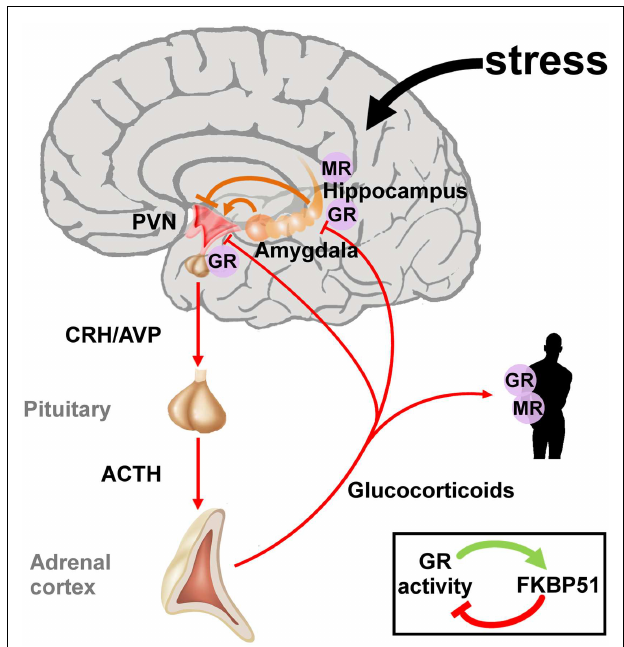
FIGURE 2 |The hypothalamic-pituitary-adrenal axis integrates and mediates the stress response to early life and later on adversity .The perception of real and/or presumed physical and social threats causes activation of the hypothalamic-pituitary-adrenal axis. Anxious states arise from activation of the amygdala and magnify the stress response via neuronal projections to the paraventricular nucleus (PVN).The hippocampus plays an important role in the assessment of stressors and as a site of glucocorticoid receptor (GR) mediated negative feedback regulation. Release of the hypothalamic neuropeptides corticotrophin-releasing hormone (CRH) and arginine vasopressin (AVP) promotes the synthesis and secretion of adrenocorticotrophin (ACTH), a posttranslational cleavage product of anterior pituitary pro-opiomelanocortin mRNA (POMC). ACTH in turn stimulates the release of glucocorticoids from the adrenal glands. These hormones circulate throughout the whole body and the brain and bind to intracellular nuclear steroid receptors. Hippocampal mineralocorticoid (MR) receptors act to the onset of the stress response, while GR at the hippocampus, PVN, and anterior pituitary terminates the stress response. The GR further transactivates FKBP51 encoding a chaperon protein which curtails GR activity through a fast intracellular negative feedback